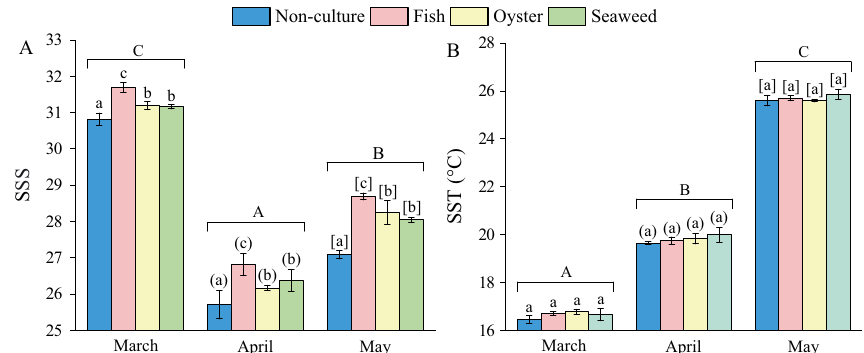
Fig. 2. (A) Sea surface sal inity (SSS) and (B) sea surface temper- ature (SST) in different areas of Shen’ao Bay from March to May 2016. Different lowercase letters, without, in round and in square brackets above the columns rep- resent statistically different re- sults in March, April and May, respectively. Different uppercase letters above the columns repre- sent statistically different results among areas in March, April and May. Error bars show